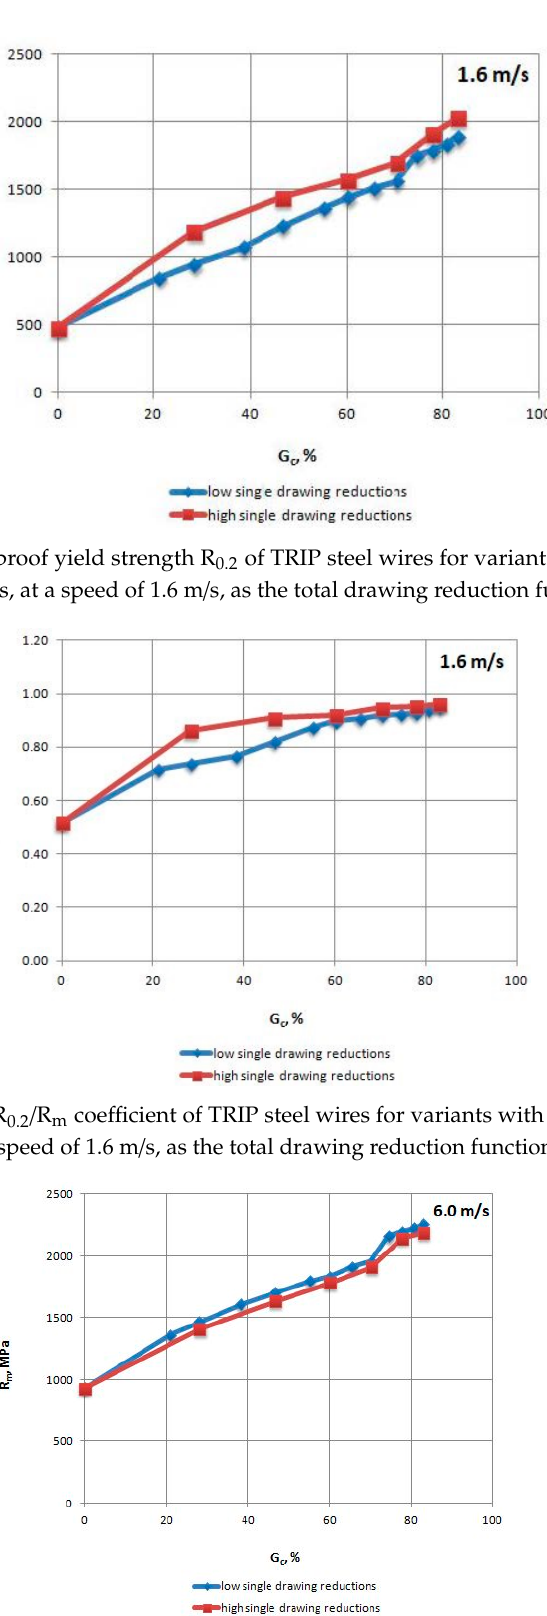
Figure 2. Change in the tensile strength R m of TRIP steel wires for variants with low and high single drawing reductions, at a speed of 1.6 m/s, as the total drawing reduction function.